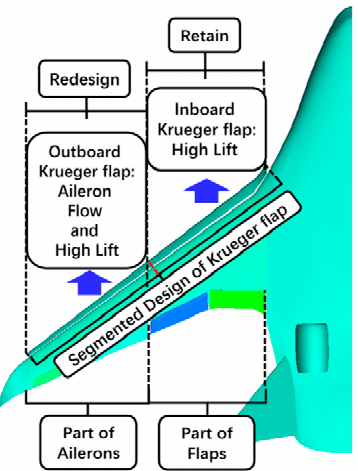
Figure 12. Plan of segmented design of Krueger flap.